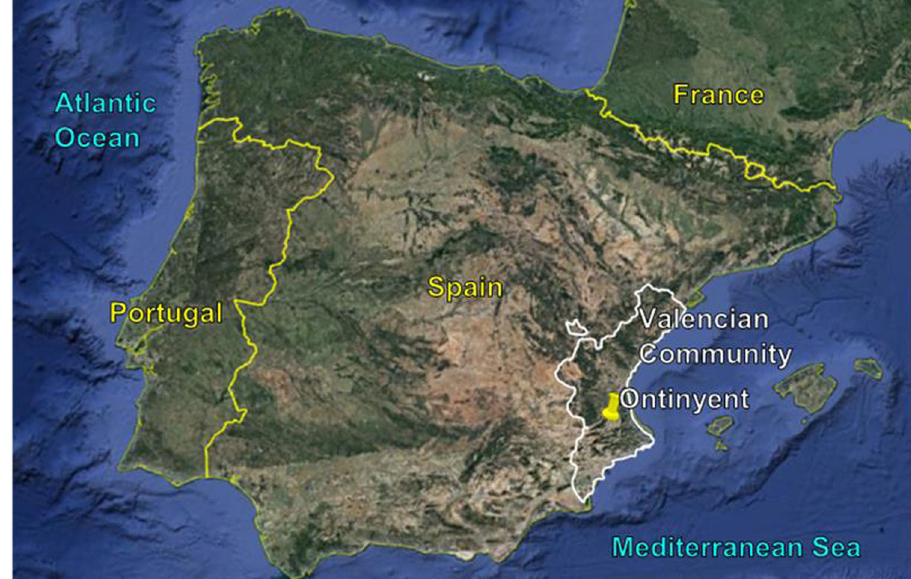
Fig. 1 Ontinyent location map. Ontinyent is located within Valencian Community (Spain). Self-elaborated map based on Google Earth data.